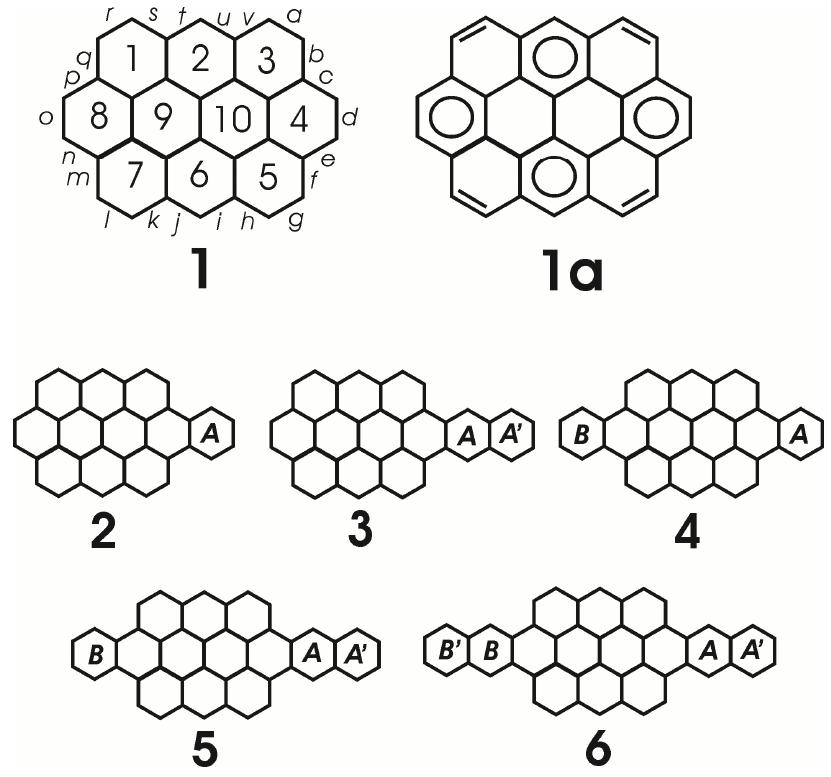
Fig. 1 – Ovalene ( 1 ), its unique Clar formula ( 1a ), its benzo- and naphthaleno-annelated derivatives studied in this work, and the labelling of their